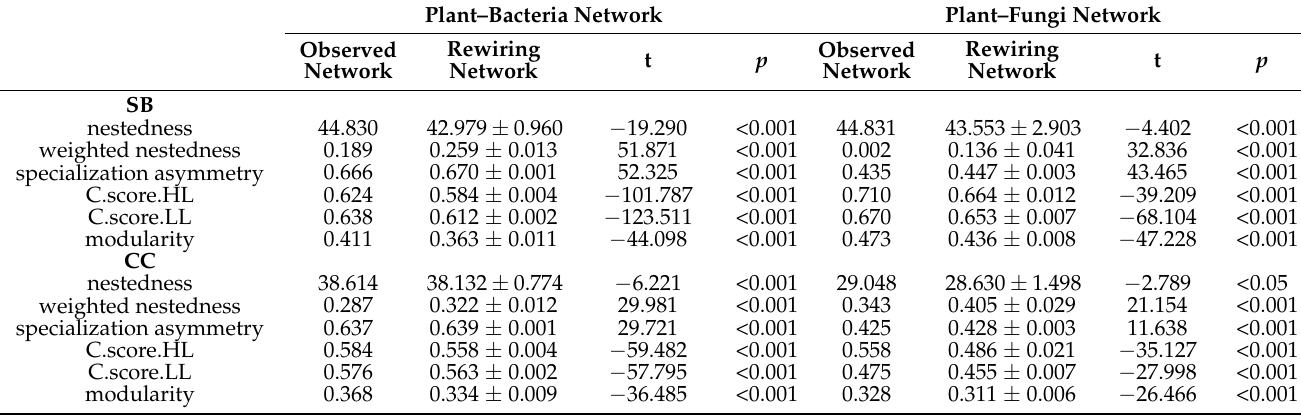
Table A4. Comparison of observed and random network topological characteristics in the four forest